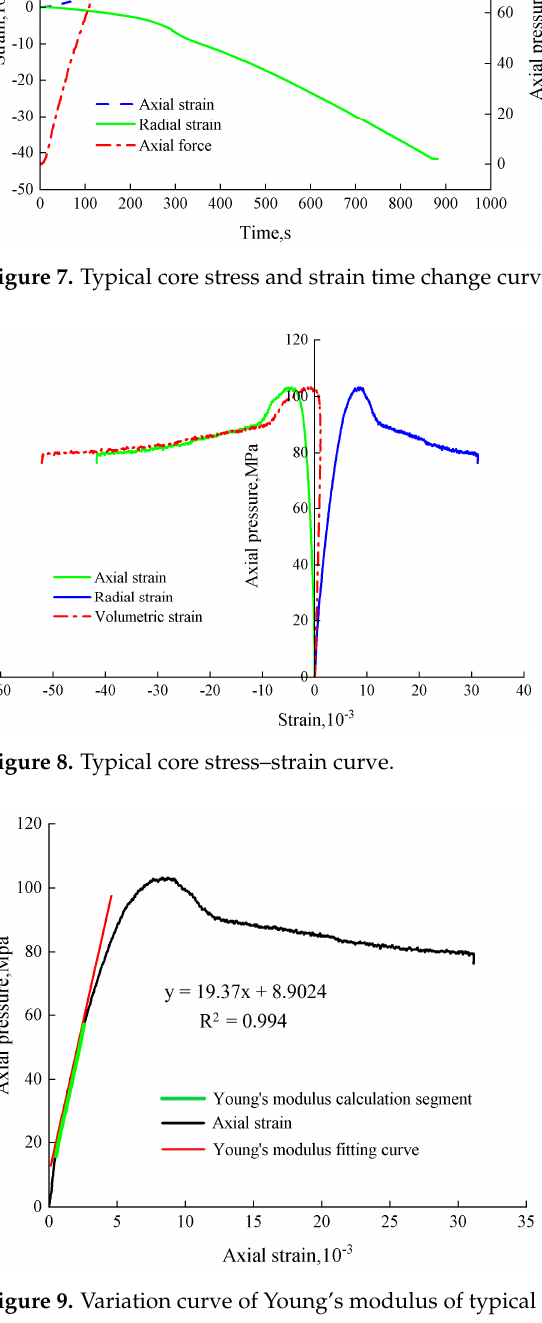
Figure 10. Variation curve of Poisson’s ratio of typical cores. Figure 11 shows the peak pressure of triaxial compression of 12 groups of core sam- ples. The analysis data showed that the maximum compressive strength of the shale was mainly distributed in the range of 94.9 to 302.4 MPa. 103.2 183.7 127.6 105.7 94.9 109 121.3 132.5 145.2 103.8 302.4 229.9 1# 2# 3# 4# 5# 6# 7# 8# 9# 10# 11# 12#050100150200250 300350 P ea k p r e ss u r e , M P a Specimen No